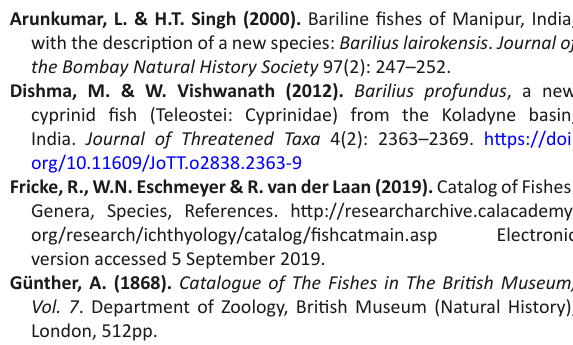
Body depth (% SL; mm)